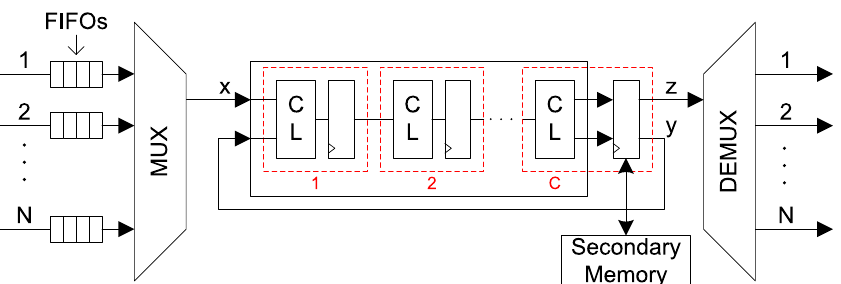
Figure 4. General virtualized hardware configuration. It consists of a C -slowed sequential logic circuit and secondary memory supporting N data input/output streams.